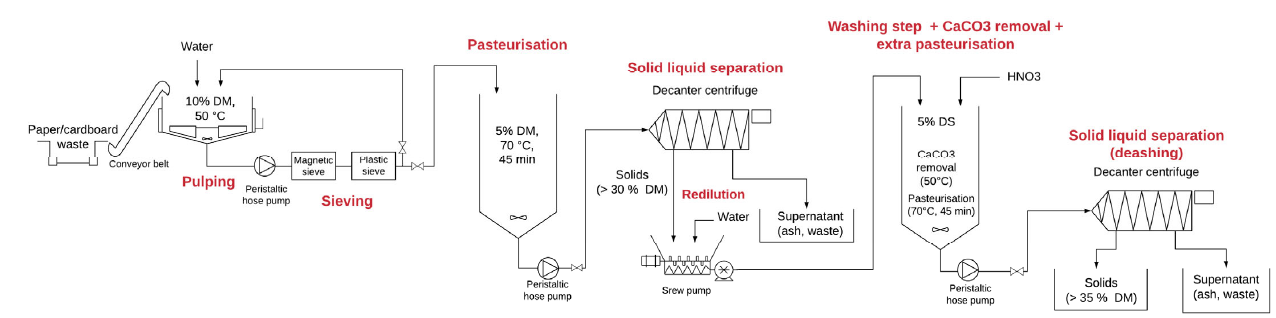
Figure 5. Pretreatment of paper and cardboard waste—process overview .